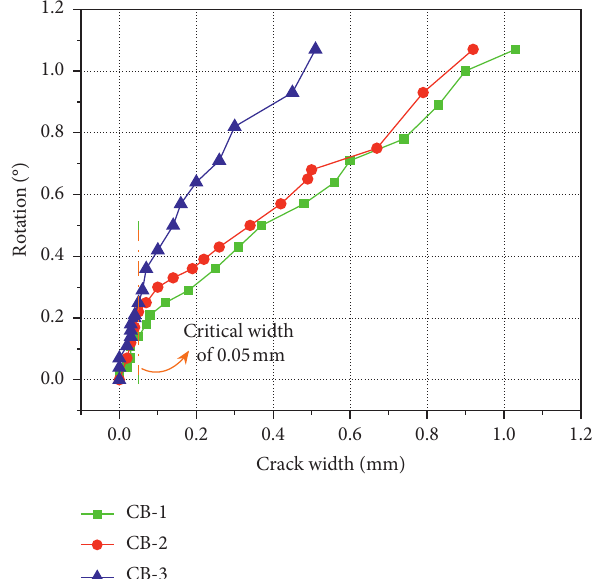
Figure 5: Rotation-crack width relationship.